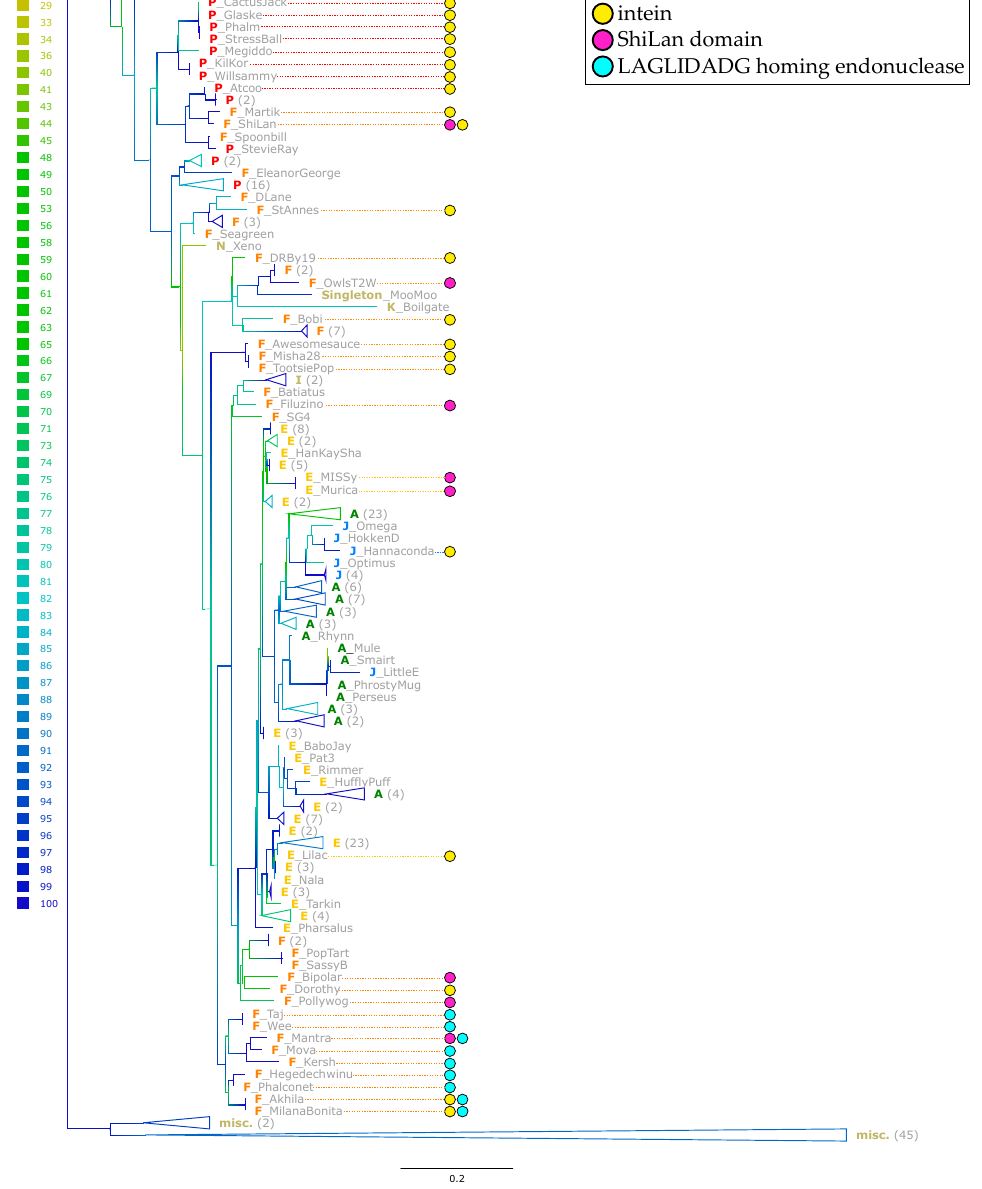
Figure 5. Phylogeny of the methylase family without considering the insertion sequences. The phylogeny was calculated with IQ-TREE from the gappy alignment with the intein, ShiLan, and second endonuclease domain removed. The cluster to which each phage belongs is denoted by a colored prefix in bold. Sequences that contain the intein ( yellow ), the ShiLan domain ( magenta ) and the second homing endonuclease domain ( cyan ) are indicated by colored circles. Branches are colored to reflect bootstrap support values. Neighboring insertion-free sequences belonging to the same phage cluster were collapsed where possible to increase readability. Numbers in parentheses indicate the number of taxa contained within the collapsed group. Collapsed groups labeled “misc.” contain insertion-free taxa from several phage clusters (AR, AS, CV, DC, EN) and three singletons. Supplementary Figure S1B contains the phylogeny without collapsed branches.